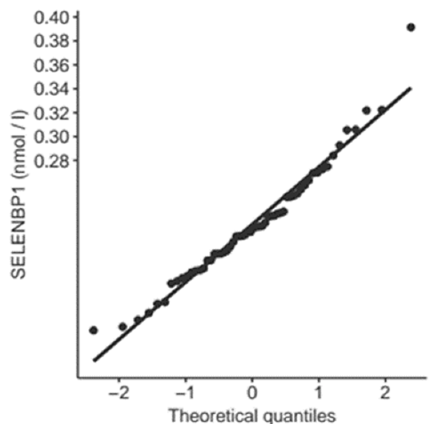
Figure 1. QQ-Plot of SELENBP1 in serum at baseline. The plot indicates the distribution of serum SELENBP1 concentrations at baseline before surgical intervention. The straight line indicates a normal distribution (R 2 = 0.96, p < 0.0001).